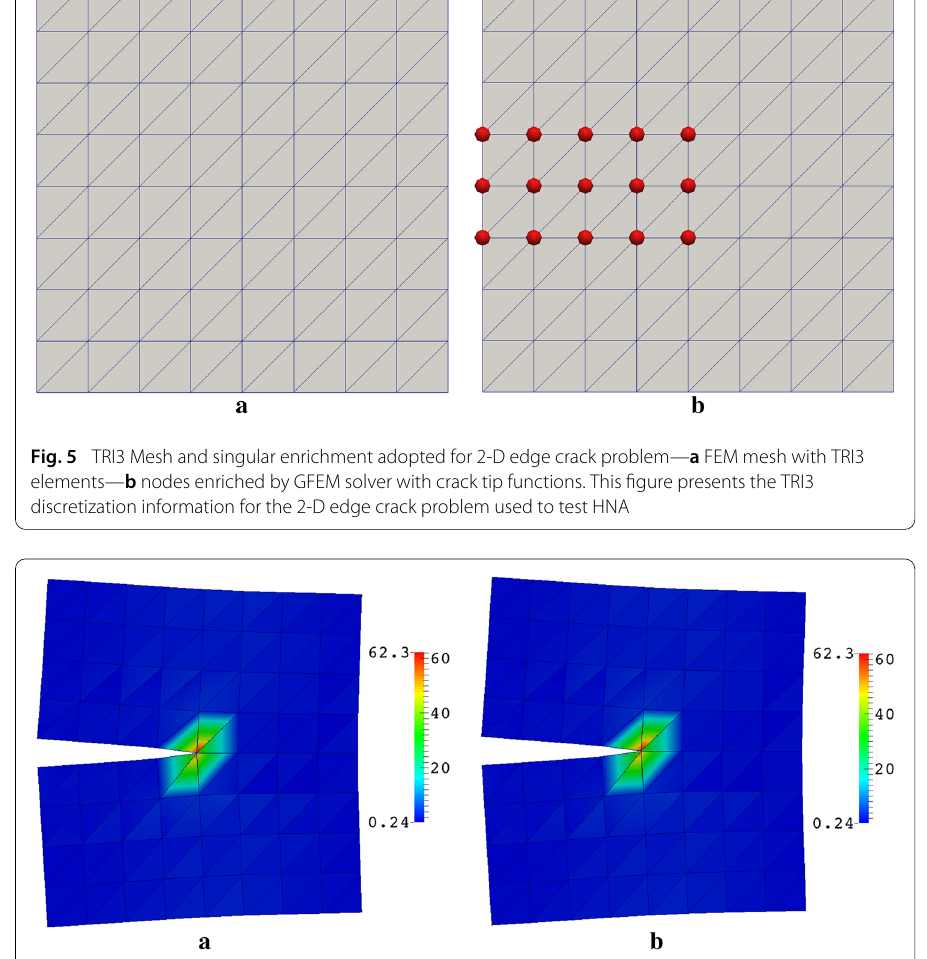
Fig. 6 Contour plot of von Mises stress computed using— a GFEM solver ISET— b HNA Abaqus-ISET solver. This figure presents von Mises results for the TRI3 2-D edge crack